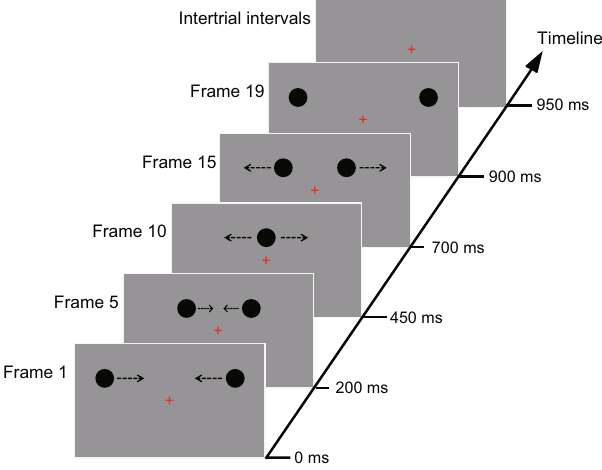
Figure 1. Schematic illustration of the visual streaming/bouncing motion display. Example shown is for a response-required trial in which two identical black discs started their motion from opposite sides, moved toward each other, coincided, moved apart, and stopped at each other’s starting points and then disappeared, followed by an intertrial interval (ITI) of 1200–1600 ms. The long solid axis (timeline) represents the onset moments of frames and each frame lasted for 50 ms. The dashed arrows near the discs indicate the direction of the motion of the discs in the next frame and are not presented in the experimental displays. On catch trials, the stimuli (except for the fixation cross) were absent from frame 10 through 19. Subjects were instructed to report their perceptual outcomes (streaming or bouncing) via a button-press on response-required trials and not respond on catch